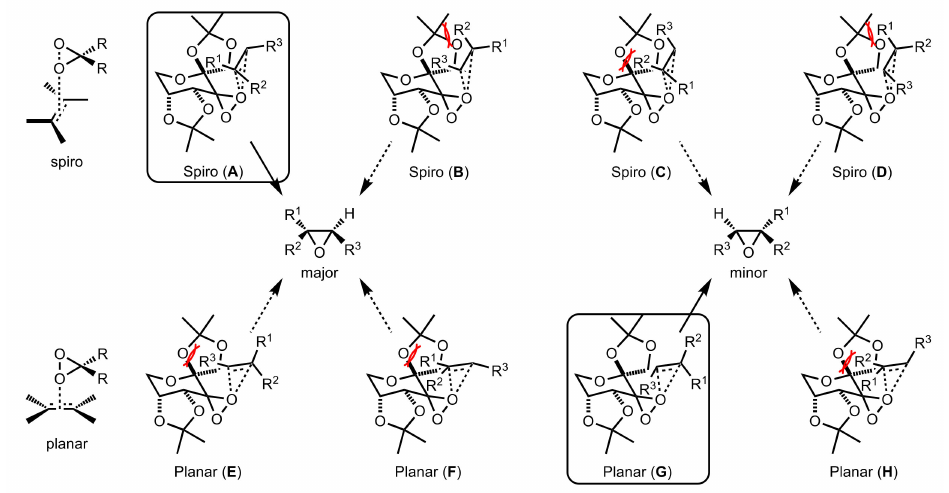
Figure 20. The proposed transition states A–H for the asymmetric epoxidation catalysed by 156a . In the same paper [74] the authors also described the synthesis of ent -156a (Scheme 36), an enantiomer of 156a , from L -fructose ( ent -154 ), obtained from L -sorbose ( 157 ) by ketal- ization, mesylation and a sequence of acid-base-acid treatment as already reported [75]. Unfortunately, the yields of the last two steps were not reported.